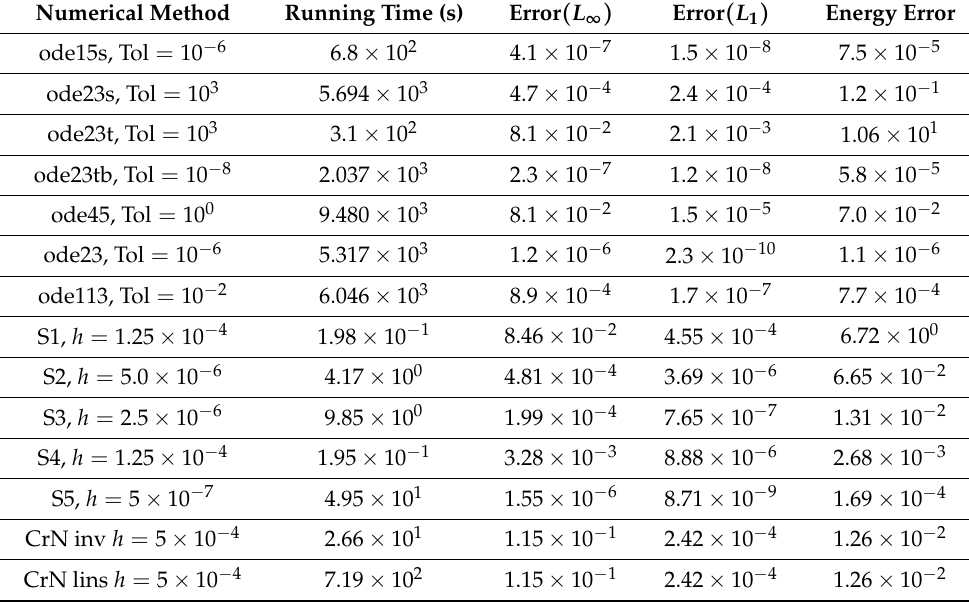
Table 2. Comparison of different algorithms for the very stiff system of 10,000 cells. Numerical Method Running Time (s)